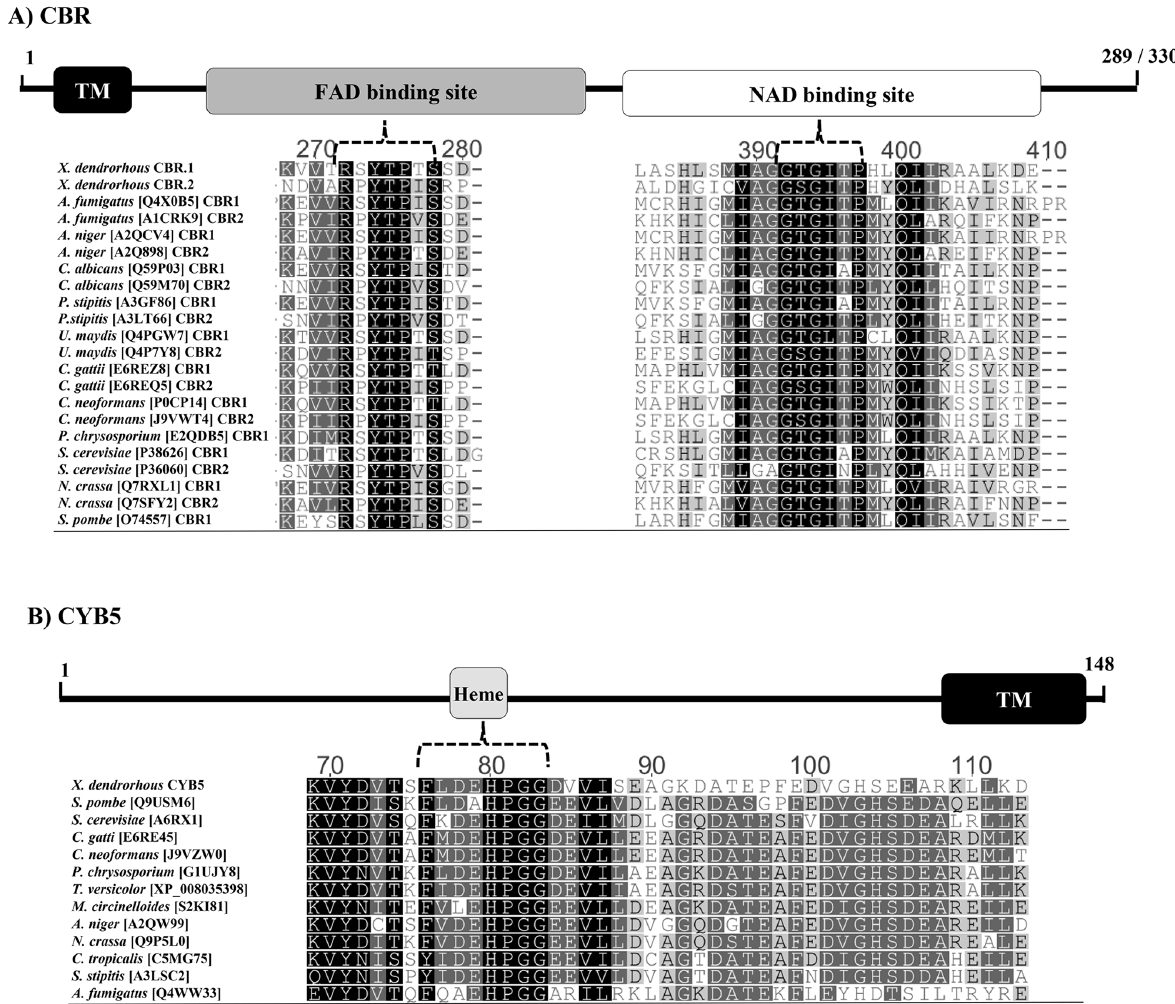
Fig 2. X . dendrorhous CBR.1, CBR.2 and CYB5 protein amino acid sequence alignment. Amino acid sequence alignment of conserved protein motives: (A) CBR and (B) CYB5. The X . dendrorhous CBR.1, CBR.2 and CYB5 are included. The UniProtKB or GenBank accession number is indicated in brackets beside the organism name and above each alignment; a scheme of the deduced X . dendrorhous protein structure is included. Tm: trans-membrane segment.